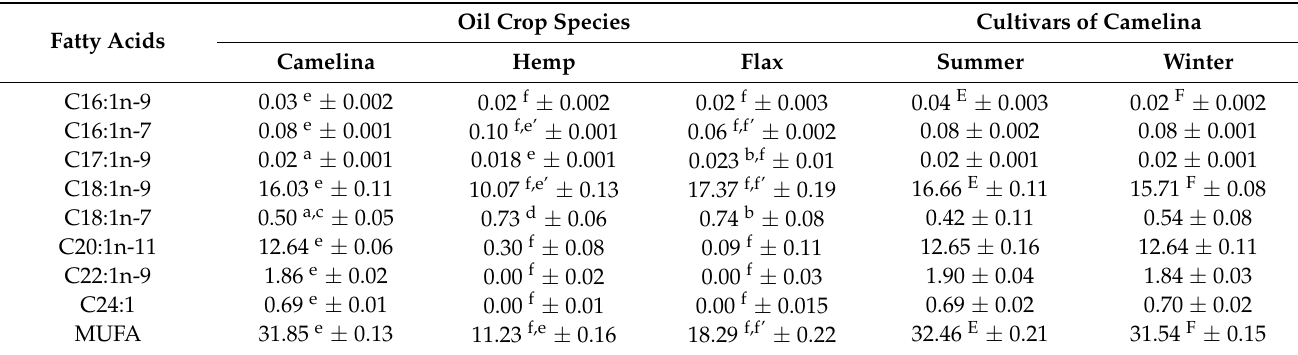
Table 3. Effects of oil crop species and camelina cultivars of different sowing seasonality on monounsaturated fatty acid (% of total FA) composition in seed lipids.